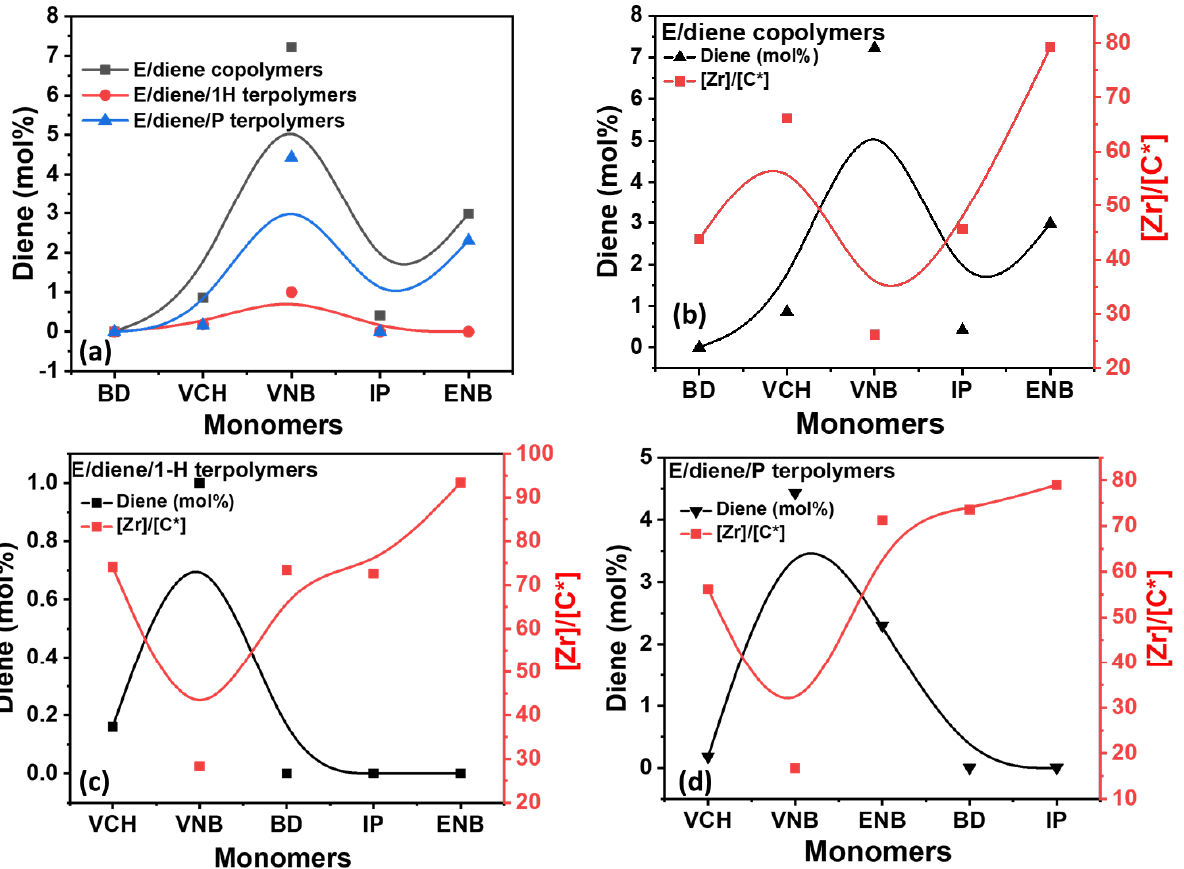
Figure 5. ( a ) Comparison between active centers and diene mole% in E/diene copolymers while ( b – d ) is the comparison of active centers and diene mole% in E/diene copolymers and E/diene/1-hexene and E/diene/P terpolymerizations.